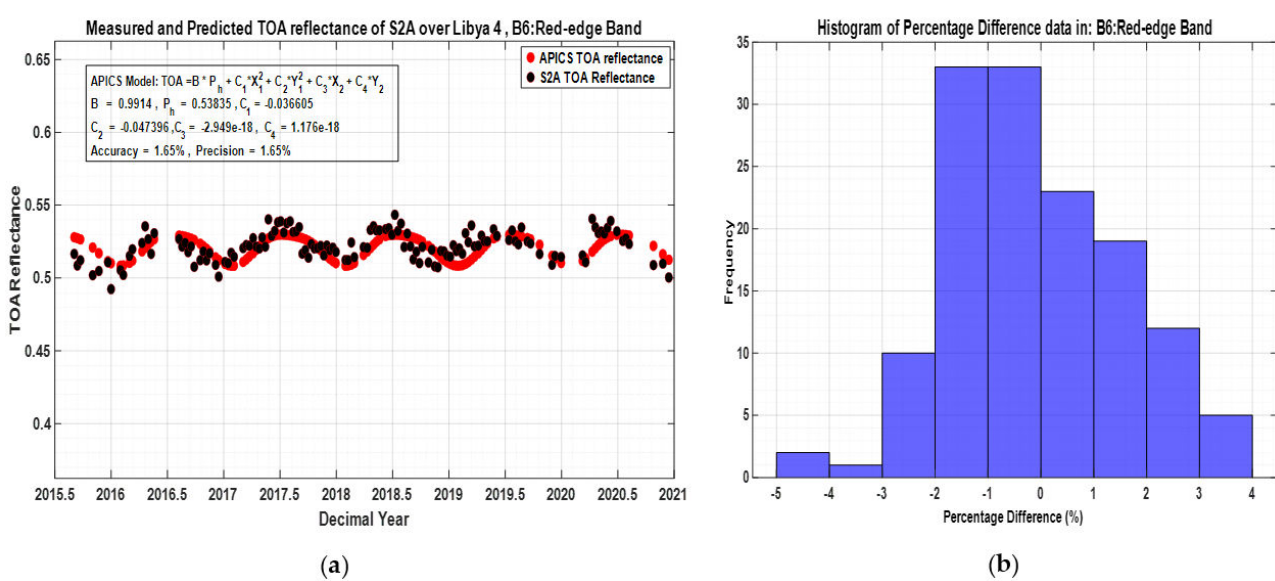
Figure 13. ( a ) S2A observation over Libya 4 (black circle) and model prediction (red circle) in Red-Edge band; ( b ) percentage difference analysis plots of the model in Red-Edge band of S2A.